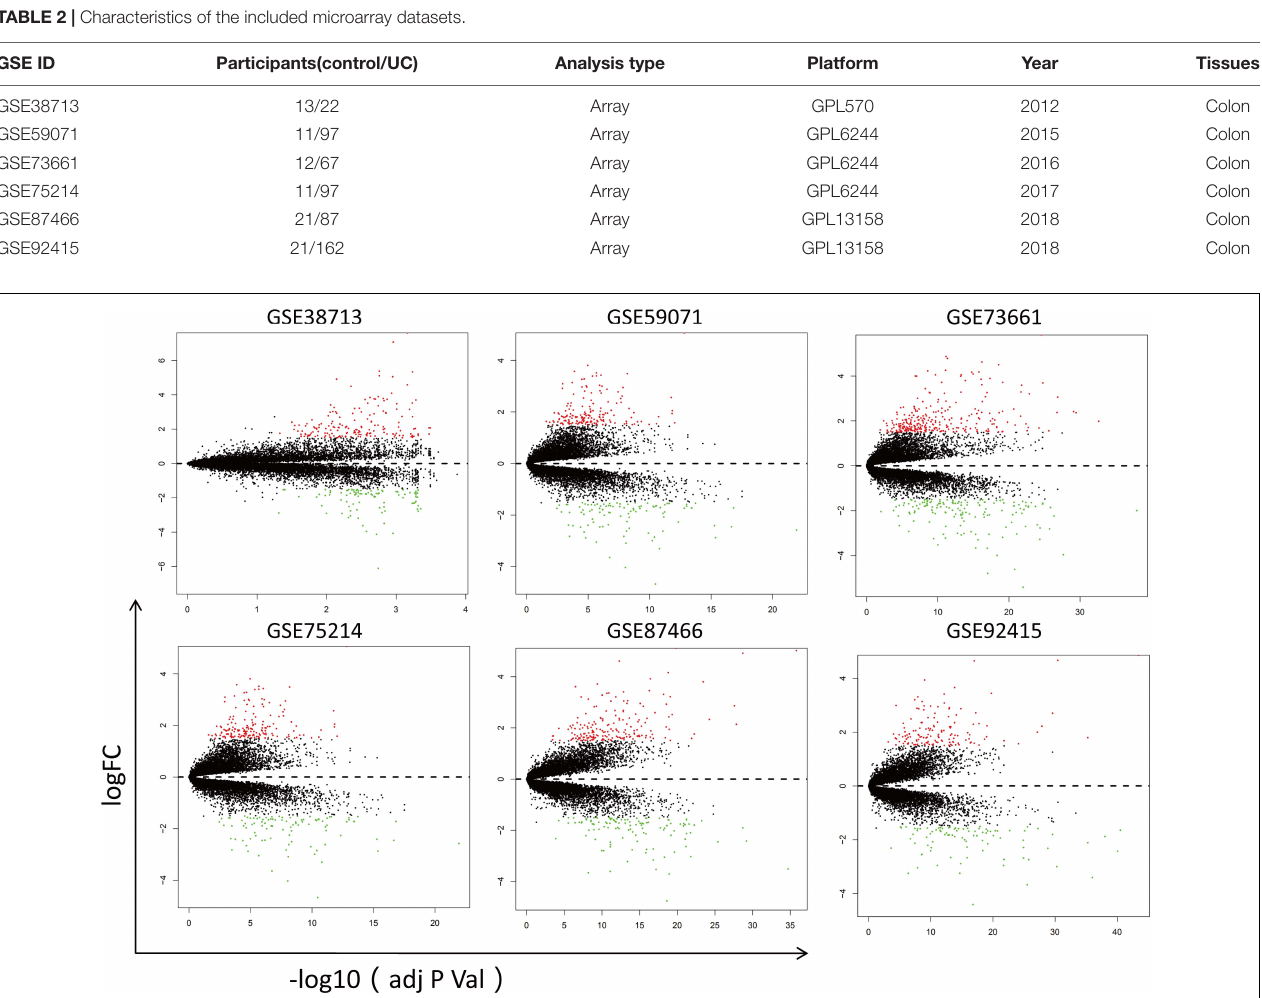
TABLE 2 | Characteristics of the included microarray datasets.